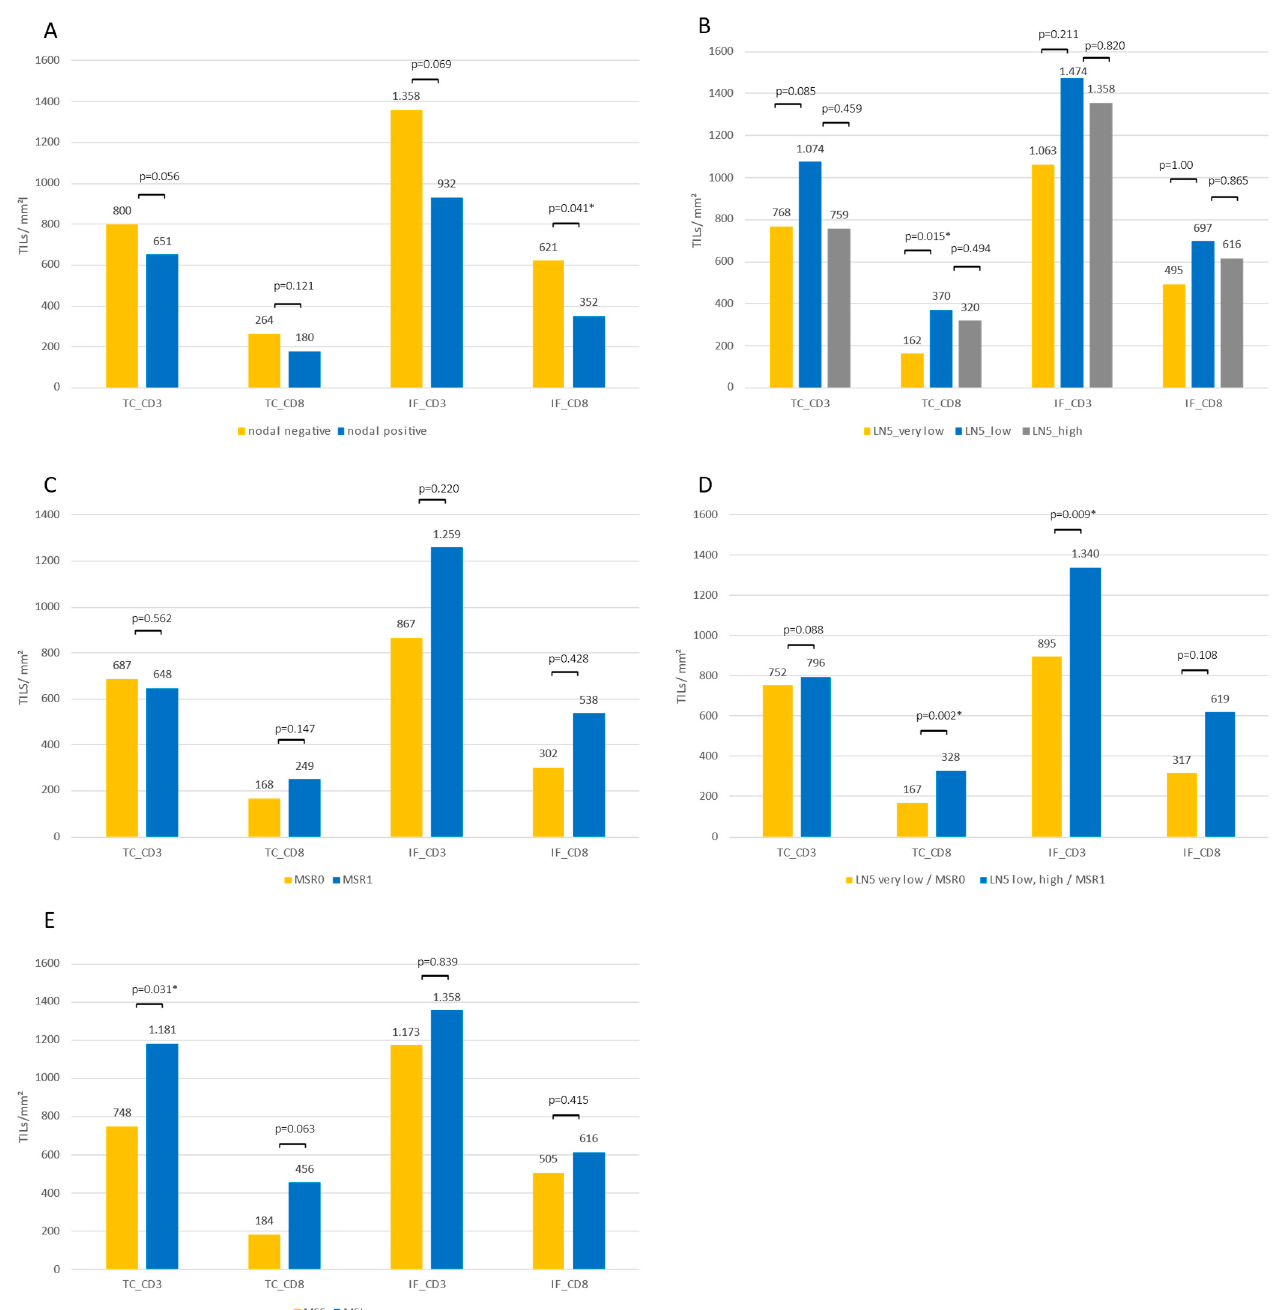
Figure 3. Median values of tumor-infiltrating lymphocytes in ( A ) nodal-negative vs. nodal-positive patients, ( B ) according to the LN5 category, ( C ) according to the MSR category, ( D ) patients with a low (LN5 very low and MSR0) or high (LN5 low and high and MSR1) lymph node immune activation, and ( E ) in microsatellite stable or instable patients. TILs: tumor-infiltrating lymphocytes; TC: tumor center; IF: invasive front. Significant p -values are marked with * for p < 0.05.